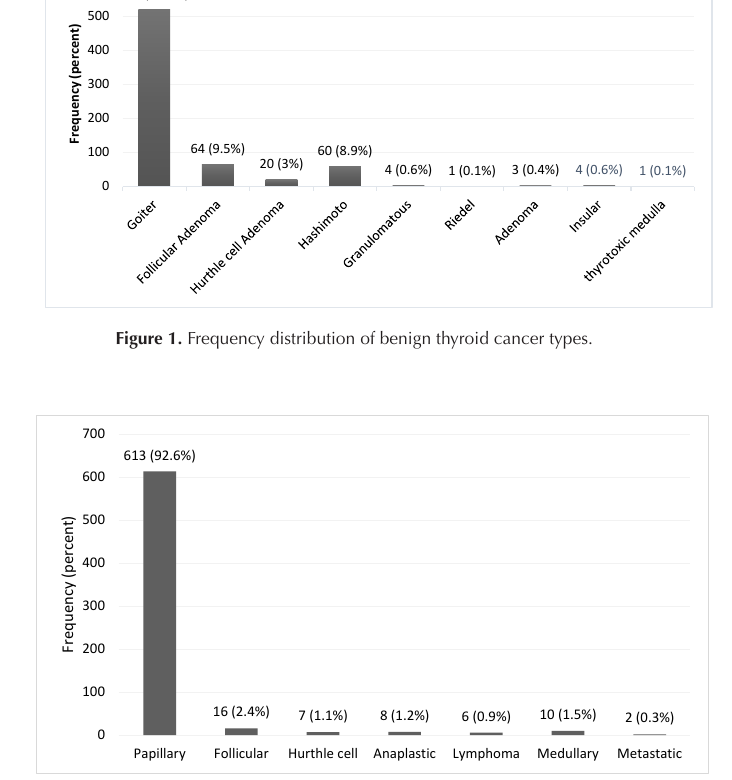
Figure 2. Frequency distribution of malignant types of thyroid cancer.